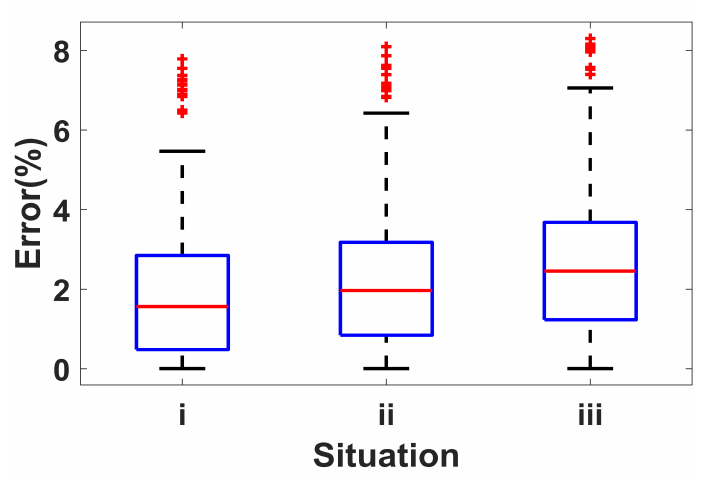
Figure 13. Box-plot evaluation error with varied situations. i : Only jumping on both feet; ii : Alternate jumping on one foot; iii : Rope jumping with one foot alternating and then both feet.